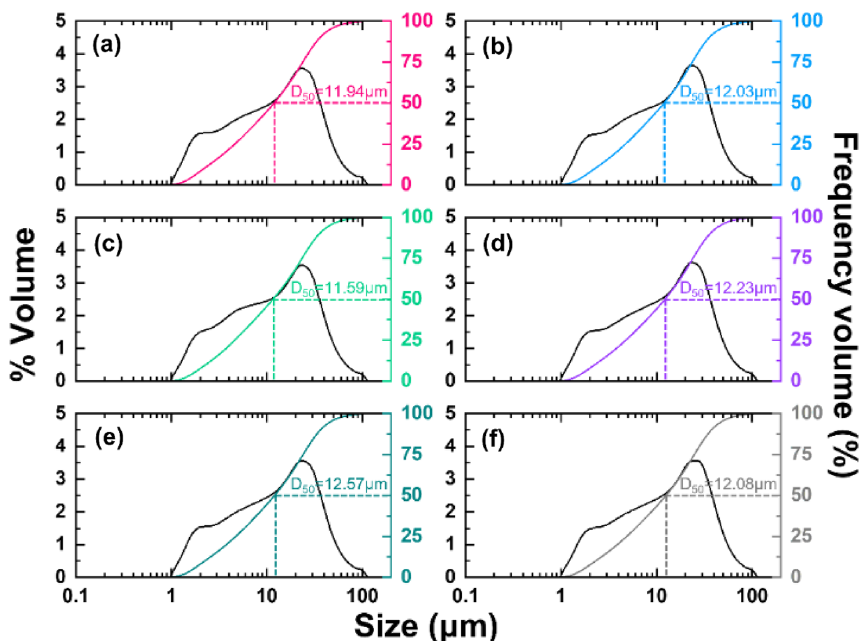
Figure 3. PSA results of glass frit under the same condition. ( a – f ) Specimens 1 to